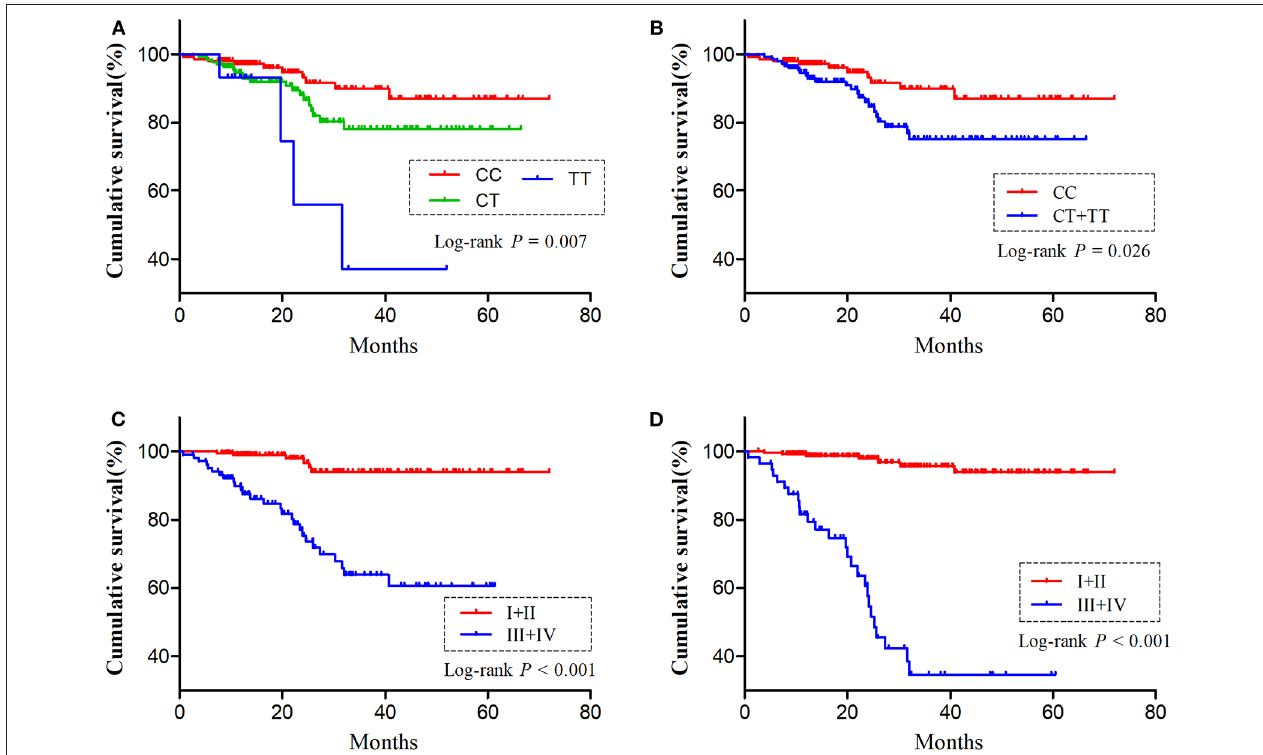
FIGURE 1 | The influence of H19 rs2839698 polymorphism on RCC survival. Kaplan-Meier survival curves illustrate RCC overall survival according to (A,B) different H19 rs2839698 genotypes, (C) tumor grade (I + II vs. III + IV) and (D) clinical stage (I + II vs. III + IV).